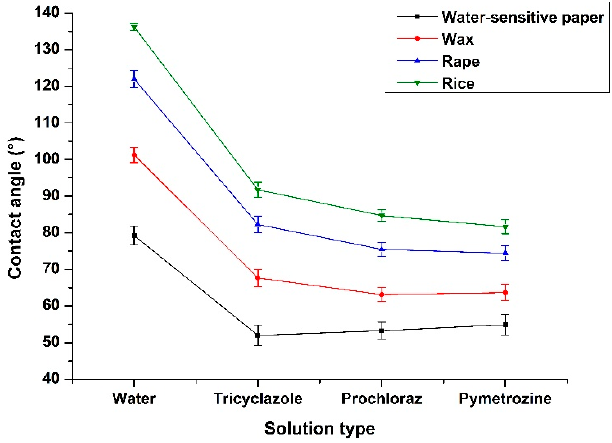
Figure 8. The variation of contact angle with the variation of solid surfaces and PPP.